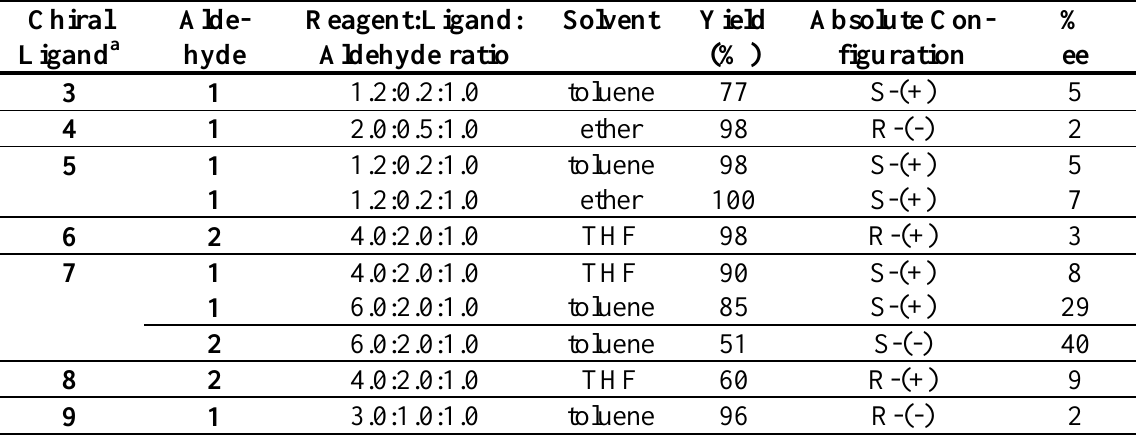
Table. Reactions of PrMgBr with 3-phenylpropanal, 1 , and benzaldehyde, 2 , in the presence of chiral Chiral Ligand a